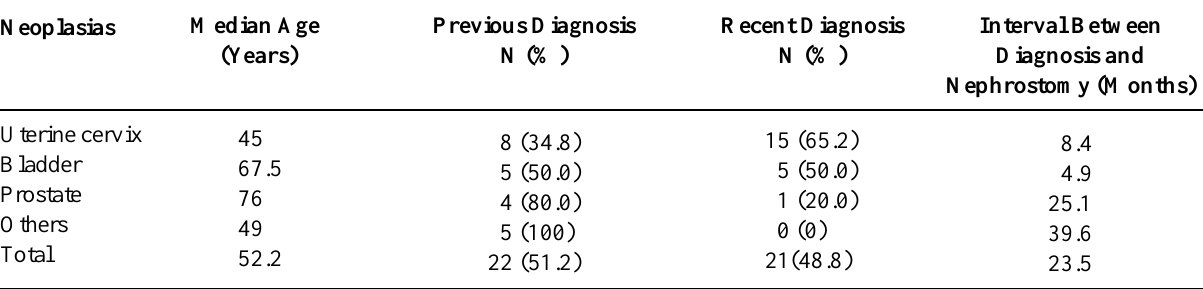
Table 2 – Diagnosis-related characteristics of different neoplastic sites. Neoplasias